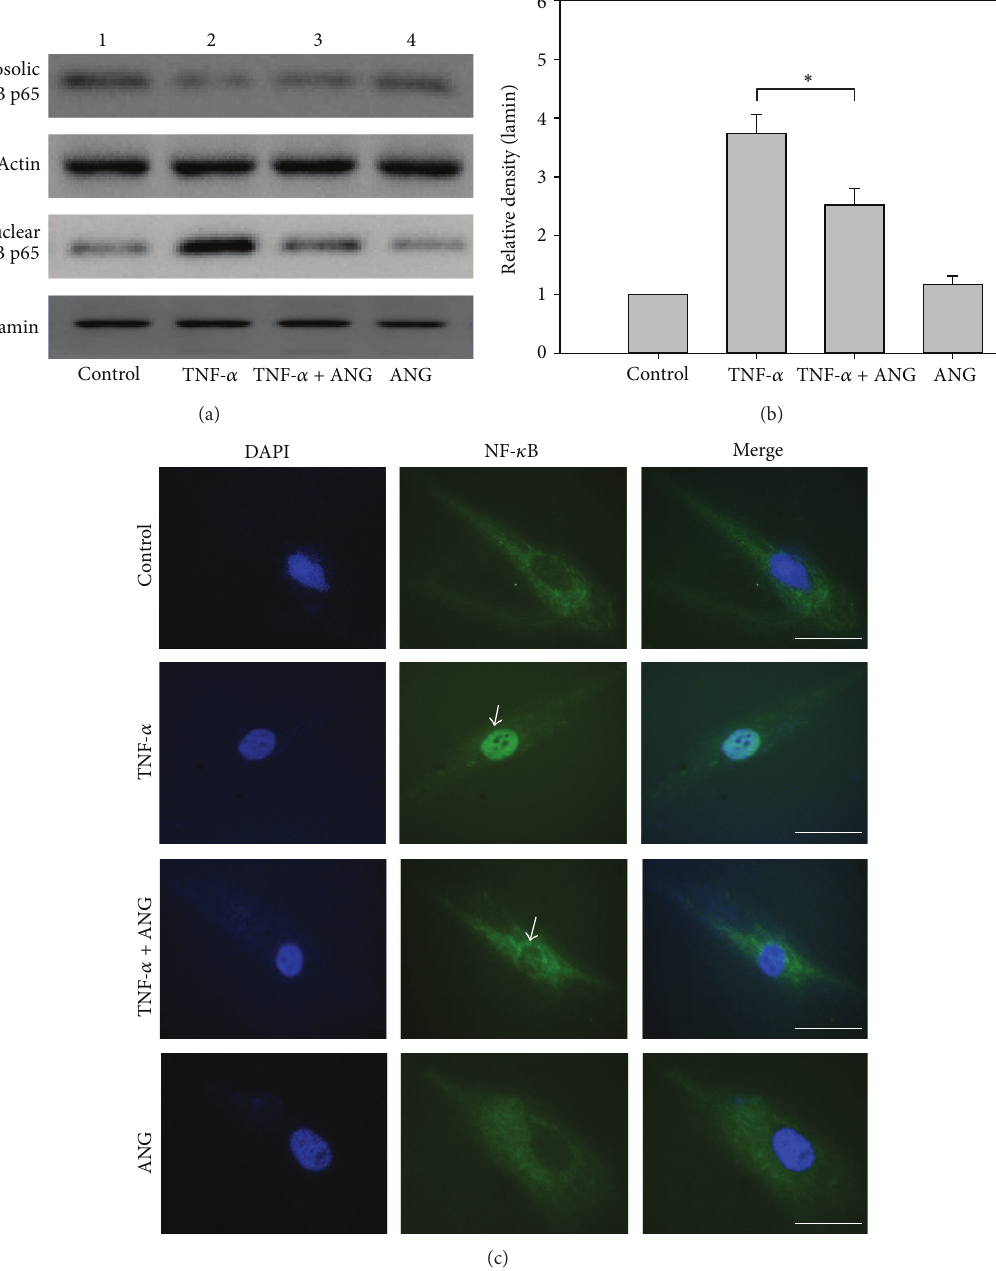
Figure 5: Western blot analyses of NF- 𝜅 B in the nucleus and cytoplasm. (a) NF- 𝜅 B nuclear translocation induced by TNF- 𝛼 was diminished after ANG treatment. ANG treatment alone did not affect NF- 𝜅 B nuclear translocation. (b) Densitometric analysis of the relative ratio of NF- 𝜅 B in cells treated with TNF- 𝛼 alone to those treated with TNF- 𝛼 +ANG. The experiments were performed in triplicate ( ∗ 𝑃 < 0.05 ). (c) Immunocytochemistry of NF- 𝜅 B in the nuclei and cytoplasm of HCFs. After treatment with ANG, the cells were fixed and then labeled with an anti-NF- 𝜅 B antibody. Immunofluorescent images at higher magnification demonstrate attenuation of the expression of NF- 𝜅 B in nucleus after treatment with ANG ((c) arrow) in cells treated with TNF- 𝛼 (scale bar, 100 𝜇 m).